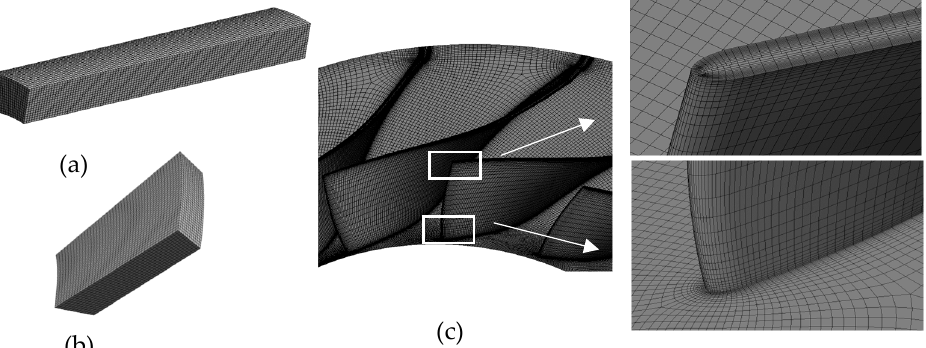
Figure 4. Computational mesh: ( a ) inlet pipe; ( b ) diffuser; ( c ) impeller.